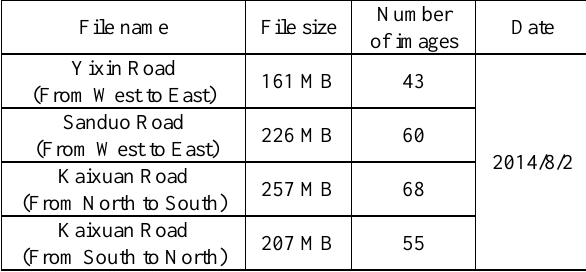
Table 2. Related information of educational test data